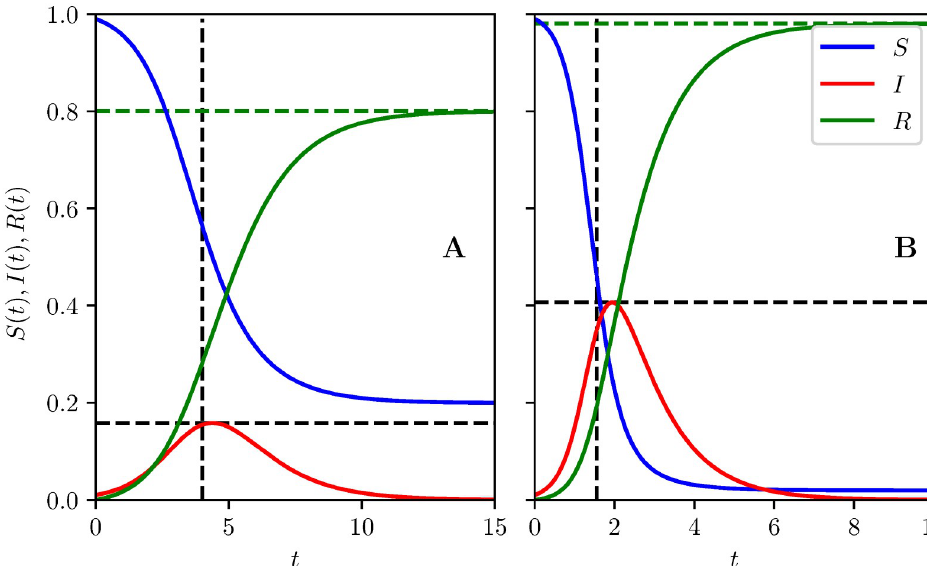
¼ b ¼ 2 and B: R ¼ b ¼ 4 with γ = 1 0 0